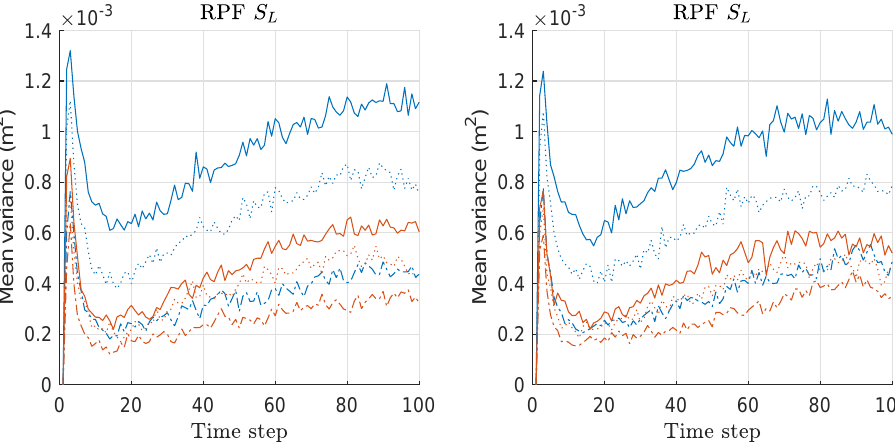
Figure 9. Mean-variance of the weights of particles over 300 runs with 1000 particles for RPF and MRPF. These results are associated with the results of MDE and mean-risk of Figures 7 and 8. Legend: line style (dash-dot: M = 2; dotted: M = 5; solid: M = 10); (line color: blue: RPF; red: